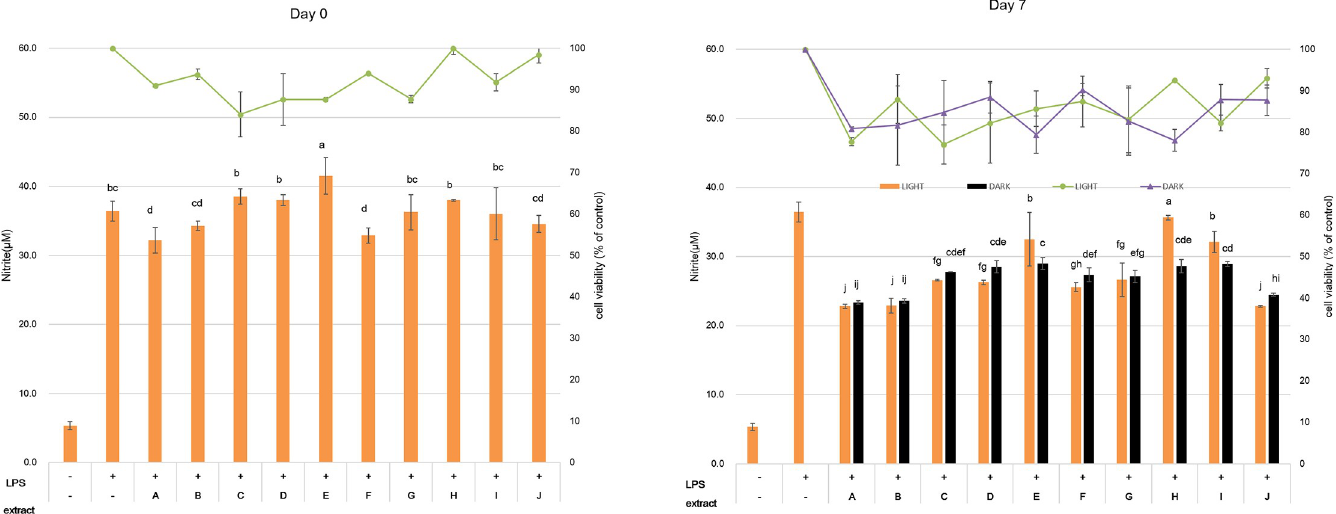
Fig 6. Effects of soybean extracts on nitric oxide production and cell viability of lipopolysaccharide (LPS)-activated RAW 264.7 cells. The cells were stimulated with LPS (1 μ g/mL) only or with LPS plus extracts (100 μ g/mL) of soybean cultivars. Values are the mean of three replicate determinations (n = 3) ± standard deviation. Bars denoted by different letters are significantly different ( p < 0.05). Left, extract of 0-day soybeans after germination; Right, extract of 7-day soybeans after germination. A, Socheongja; B, Youngwoljwinuni B/G; C, Dawonkong; D, Yaksunkong; E, Youngwoljwinuni B/Y; F, Cheongja3; G, GWS 148; H, Daewonkong; I, GWS 140; J, Taekwangkong.